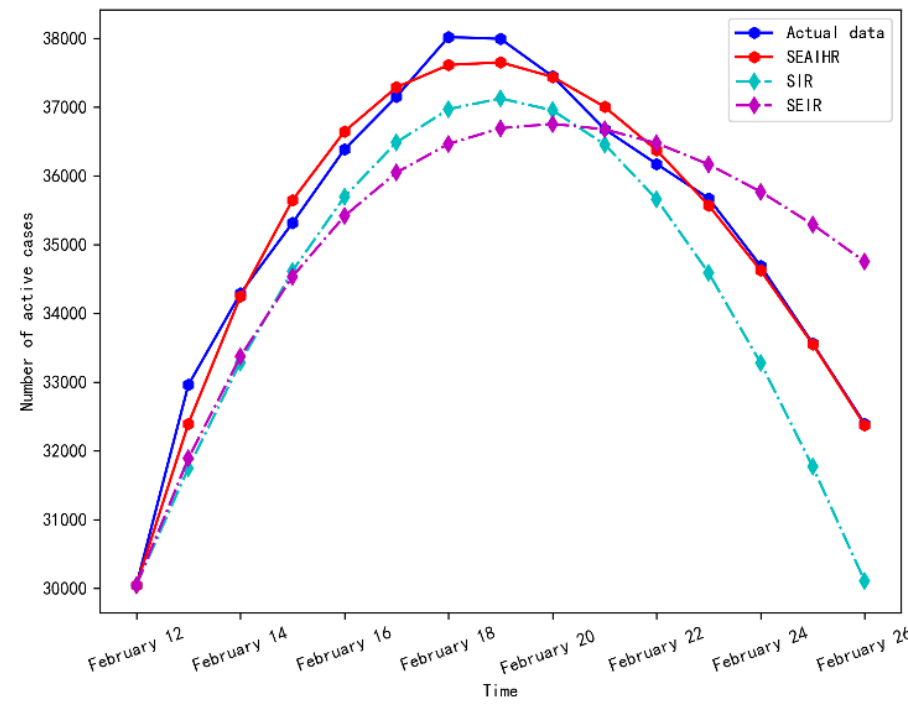
Figure 6. Simulation results comparison of stage 2.